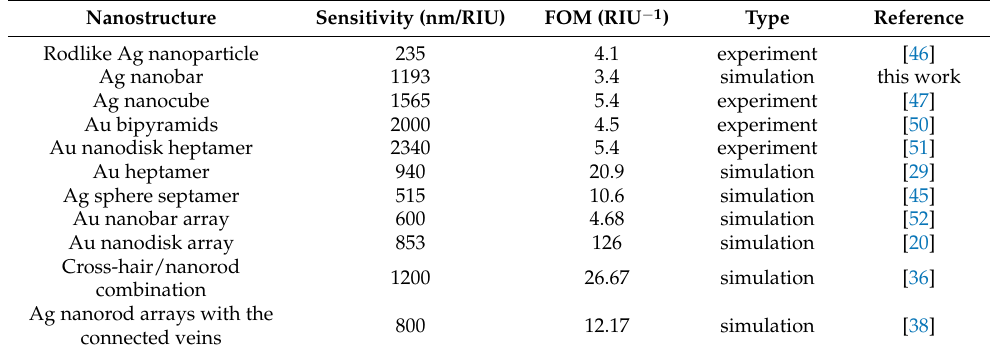
Table 1. LSPR sensitivities for nanostructures used in the experiments and